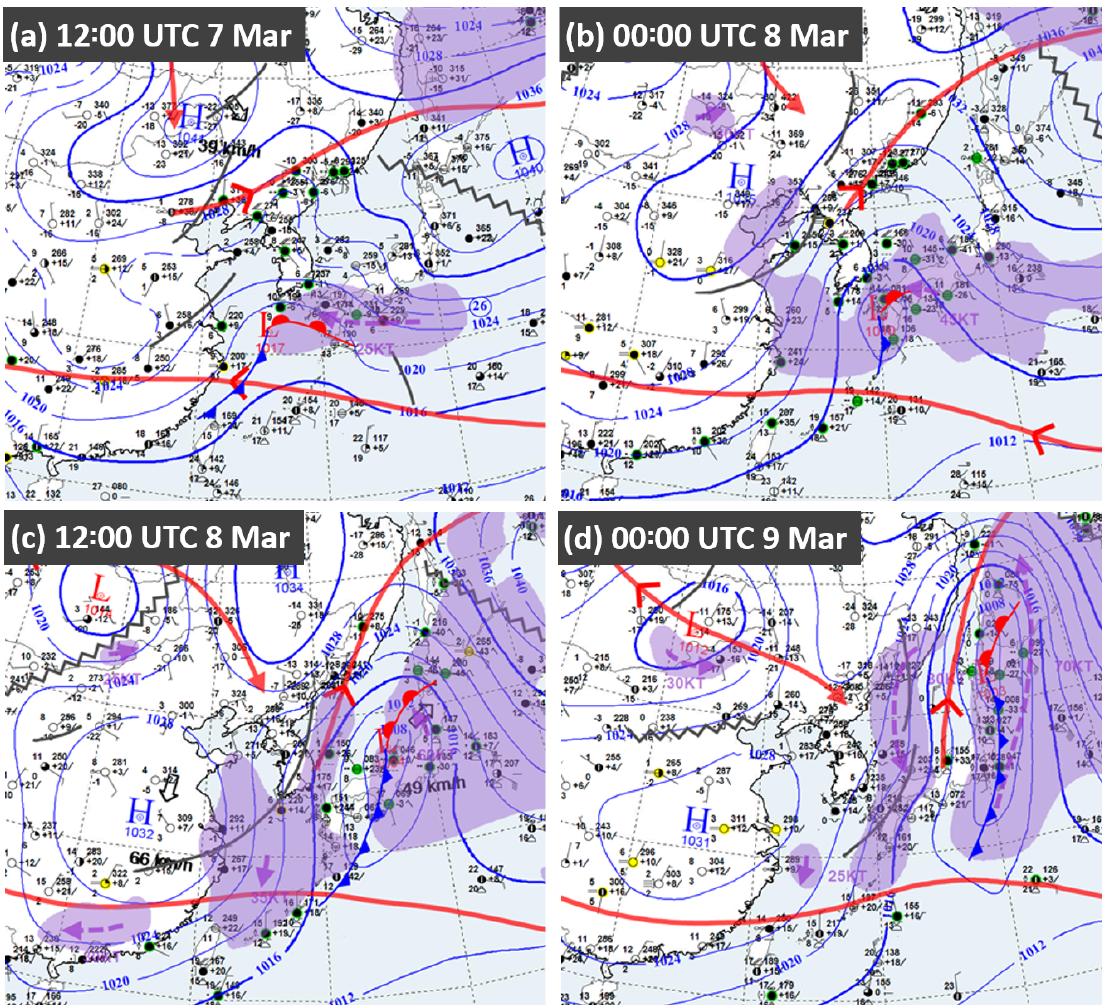
Figure 3. Same as Fig. 2, except valid at (a) 12:00UTC 7 March, (b) 00:00 UTC 8 March, (c) 12:00UTC 8 March, and (d) 00:00UTC 9 March 2018.